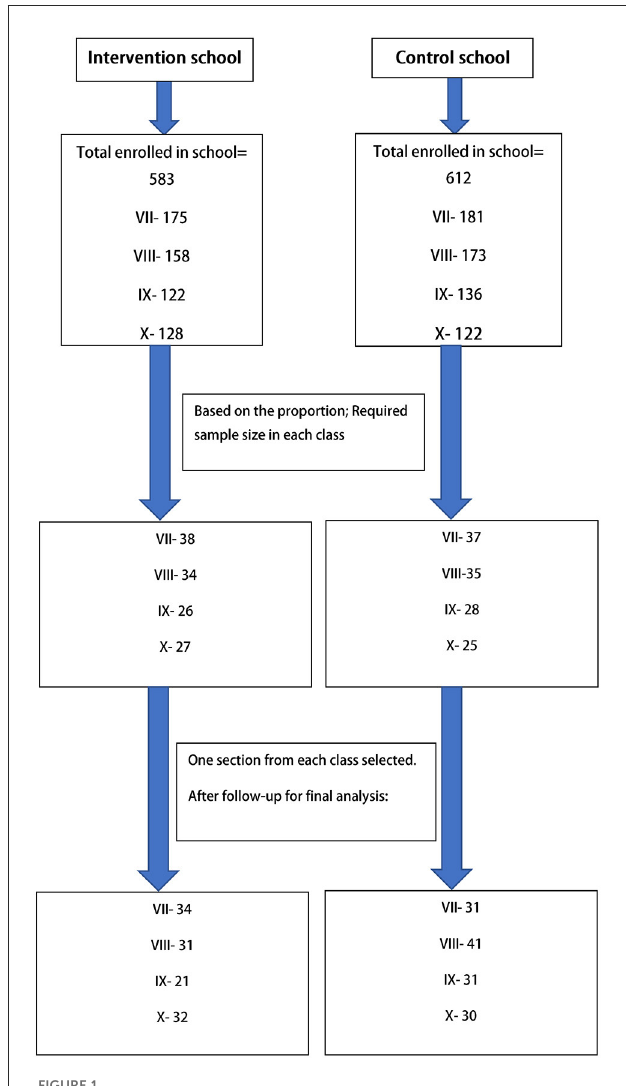
FIGURE1 Flow diagram showing the selection of study